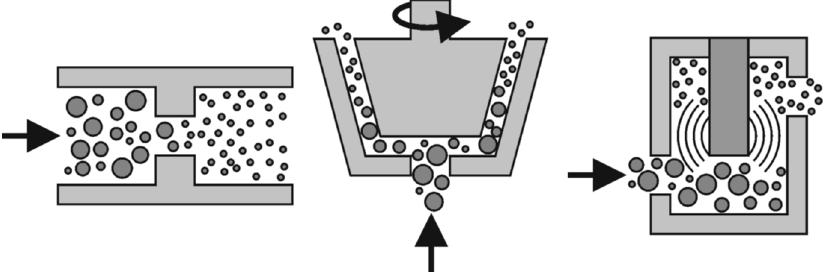
Figure 1. Schematic representation of classic emulsification methods. Left: high-pressure homogenizer, middle: rotor-stator system. Right: ultrasound [9] (reproduced with permission from the author).